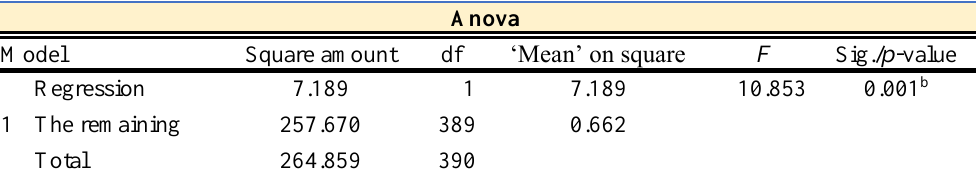
Table 3. ANOVA Applying Methods for Managerial Staff Performance